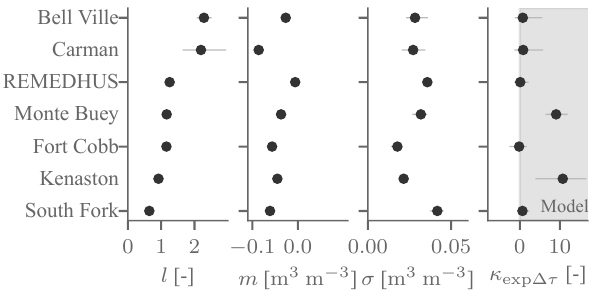
Figure 5. The time-average error properties l (sensitivity), m (ad- ditive bias) and σ (noise standard deviation), and the κ parameter (sensitivity of SMAP’s noise level to (cid:49)τ ) as inferred for all network sites. Meaning of markers and lines as in Fig.